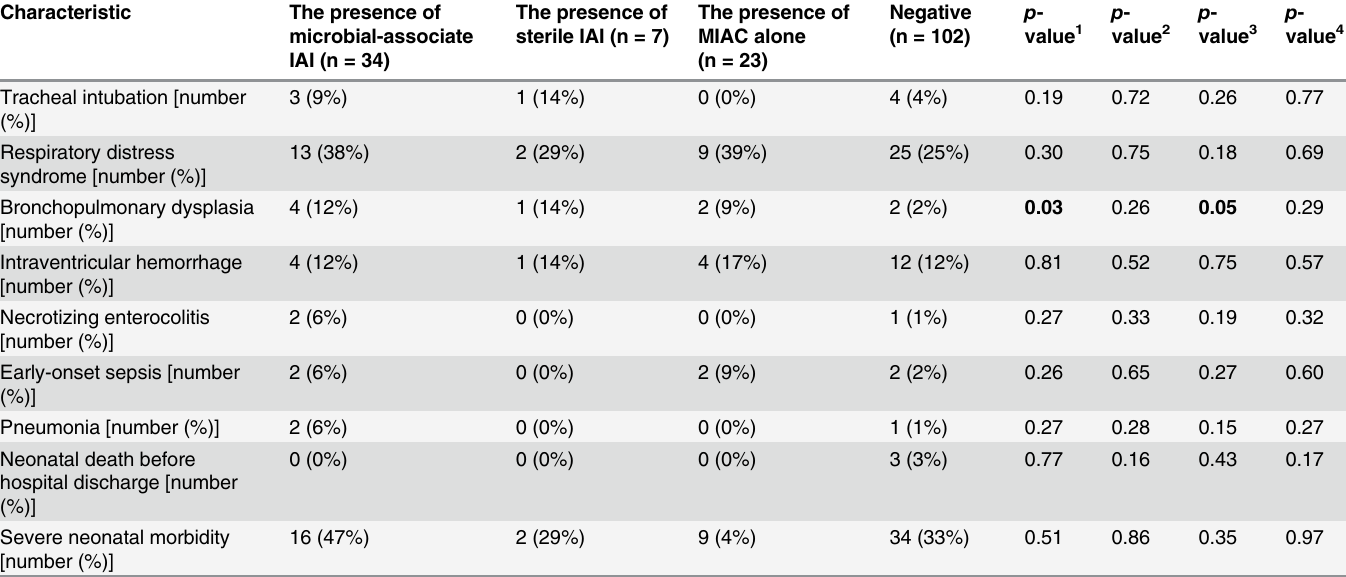
Abbreviations: IAI: Intraamniotic in fl ammation, MIAC: microbial invasion of the amniotic cavity. Severe neonatal morbidity was de fi ned as a need for intubation and/or respiratory distress syndrome and/or pneumonia and/or bronchopulmonary dysplasia and/or intraventricular hemorrhage and/or necrotizing enterocolitis and/or early-onset sepsis and/or late-onset sepsis and/or neonatal death before hospital discharge. Retinopathy of prematurity (n = 1) and late onset sepsis (n = 2) was not considered in the analysis because of low occurrence in the cohort. Categorical variables were compared using the Fisher ’ s exact test or the chi-square test. Spearman partial correlation was used to adjust the data for the gestational age at delivery. Statistically signi fi cant results are marked in bold. p -value 1 : the comparison among four groups with the Fisher ’ s exact tests (exact 2-tailed p -value). p -value 2: the comparison among four groups with the adjustment for gestational age at delivery. p -value 3 : the comparison among women with microbial-associated intraamniotic in fl ammation, microbial invasion of the amniotic cavity alone, and negative women with the chi-square test. p -value 4 : the comparison among women with microbial-associated intraamniotic in fl ammation, microbial invasion of the amniotic cavity alone, and negative women with the adjustment for gestational age at